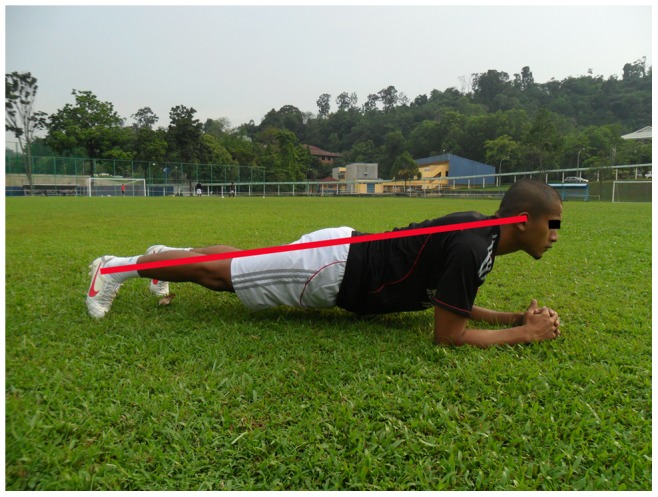
The bench static.